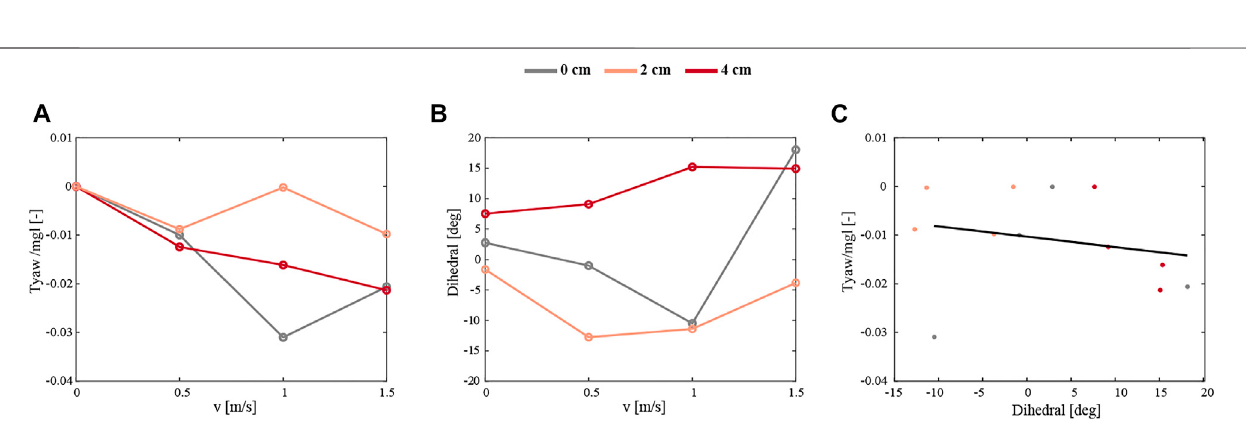
Frontiers in Robotics and AI |